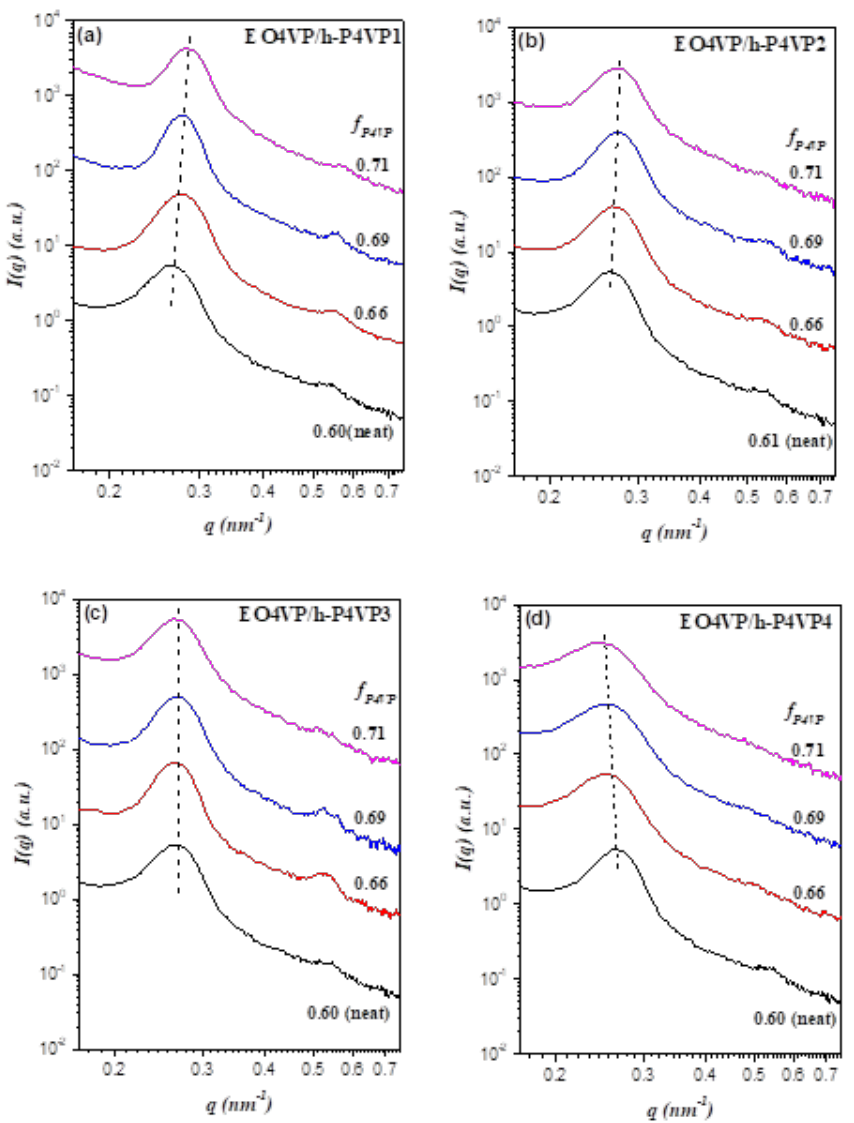
Figure 4. Composition-dependent SAXS profiles at 180 °C of the blends of EO4VP with ( a ) h-P4VP1, ( b ) h-P4VP2, ( c ) h-P4VP3, and ( d ) h-P4VP4. The dashed lines are drawn to illustrate the effect of composition on primary peak position. The primary peak shifted to higher q with increasing f P4VP for the blends with h-P4VP1 and h-P4VP2, while the peak position remained largely unperturbed for h-P4VP3 blend. The peak of h-P4VP blend shifted to lower q with increasing f P4VP